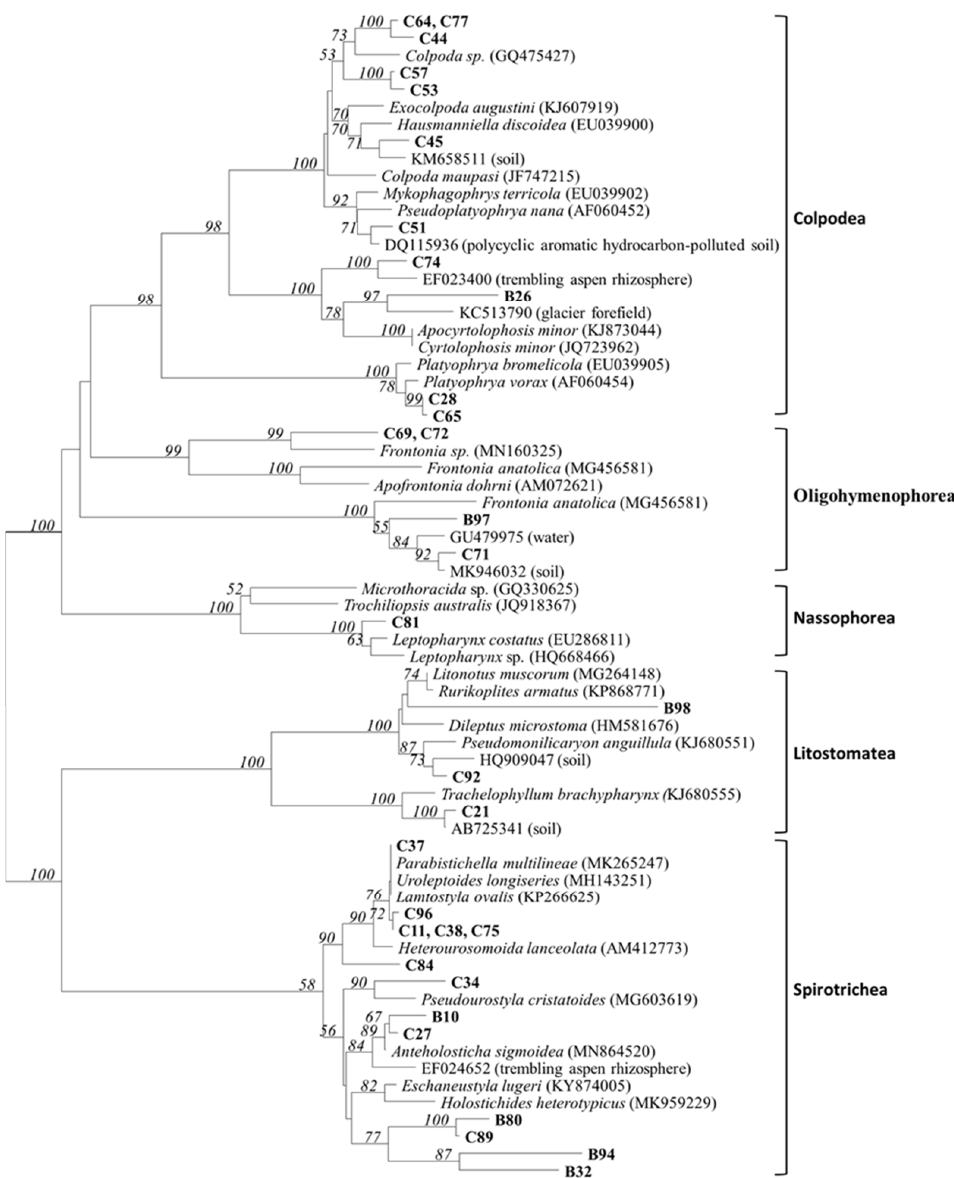
Figure 3. Neighbor-joining tree of sequenced 18S rRNA gene products. In boldface are reported the sequences obtained in this study. Sequences retrieved from GeneBank database are also reported and their accession numbers are given. Bootstrap values after 1000 replicates higher than 50% are reported at branch nodes. Table 4. BLAST analysis of 18S rDNA fragments selected from Pratomagno DGGE and belonging to the Ciliophora Phylum. The sequence coverages of the nearest matches were always 100%. The taxonomical identification was achieved by using different sequence similarity thresholds: a similarity of ≥ 97%, ≥ 95%, ≥ 90%, ≥ 85%, ≥ 80%, and ≥ 75% for assignment at the species-, genus-, family- , order-, class-, and phylum-level identification, respectively [33].